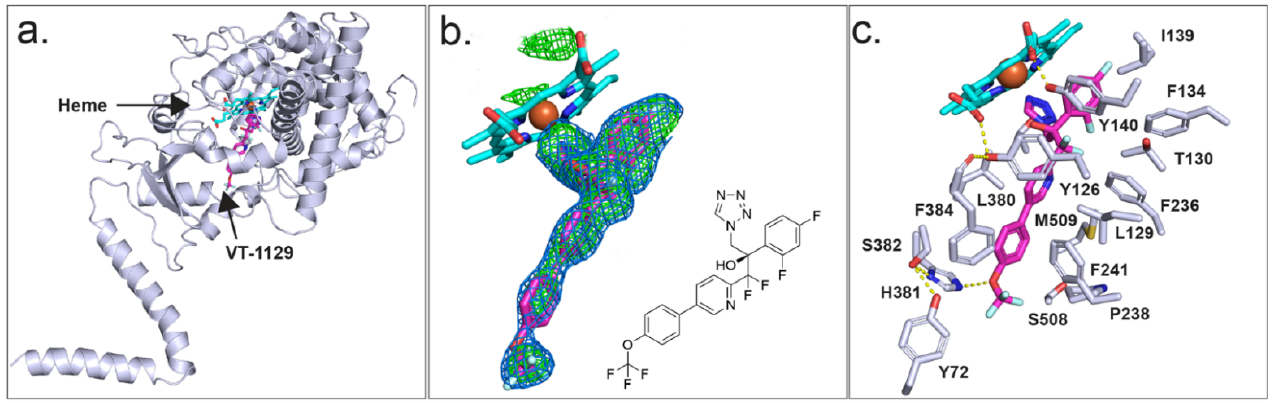
Figure 7. Crystal structure of ScCYP51-6×His in complex with VT-1129. ( a ) Full-length structure of ScCYP51-6×His in complex with VT-1129. ( b ) OMIT map for VT-1129 (Fo-Fc map (green mesh) contoured at 3 σ ; 2Fo-Fc map (blue mesh) contoured at 1 σ ). The Fo-Fc map was calculated using Fcalc refined from coordinates with no ligand at the active site. The 2Fo-Fc map was calculated following the final refinement. The chemical structure of VT-1129 is shown at the bottom right-hand corner. ( c ) Residues within 4 Å of VT-1129 are shown as white sticks. H-bonds are presented as yellow dashed lines. The ScCYP51 cartoon is white, VT-1129 is shown as magenta and the heme is depicted as cyan sticks with the heme iron as an orange sphere. Nitrogen atoms are blue and oxygen atoms are red.